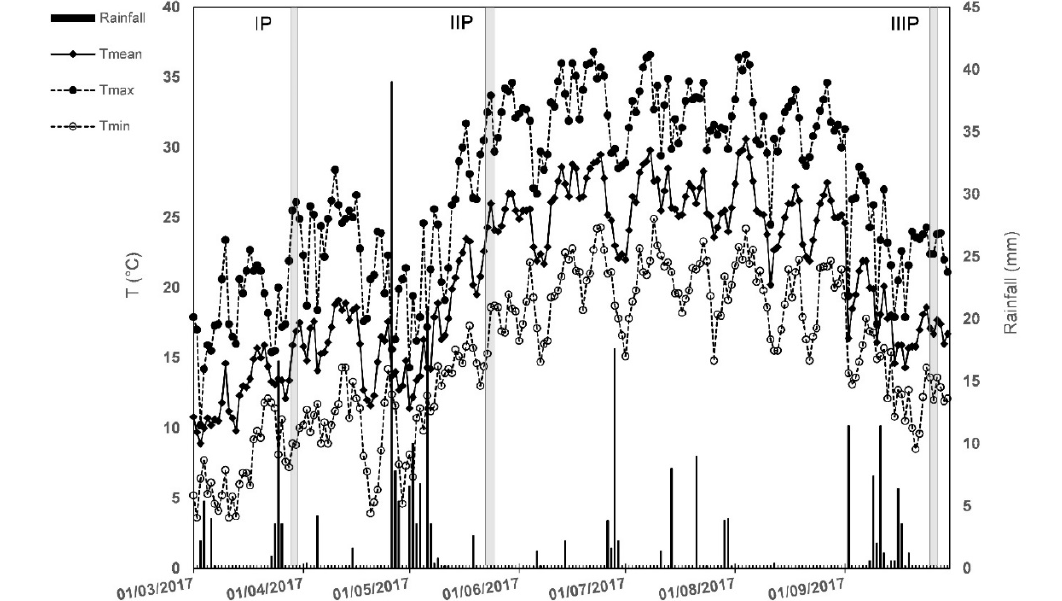
Figure 1. Trend of mean air temperature (T ), minimum air temperature (T ), maximum air temperature (T ) mean min max and rainfall during the study period (from the beginning of March to the end of September 2017). Grey bars indicated the sampling days for each of three phases considered during leaf development in Corylus . IP = first phase at developing leaf; IIP = second phase at fully developed leaf; IIIP = third phase at leaf senescence. Data from Lombardia Regional Agency for Environmental Protection, Meteorological Station of Pavia (v. Folperti), daily data for the period 1/03/2017